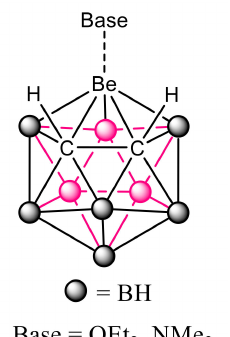
Figure 1. The two complexes described for the 3-beryl-l,2-dicarbacloso-dodecaborane(12) [26]. Strained systems have been shown to react more easily than other related non-strained systems.